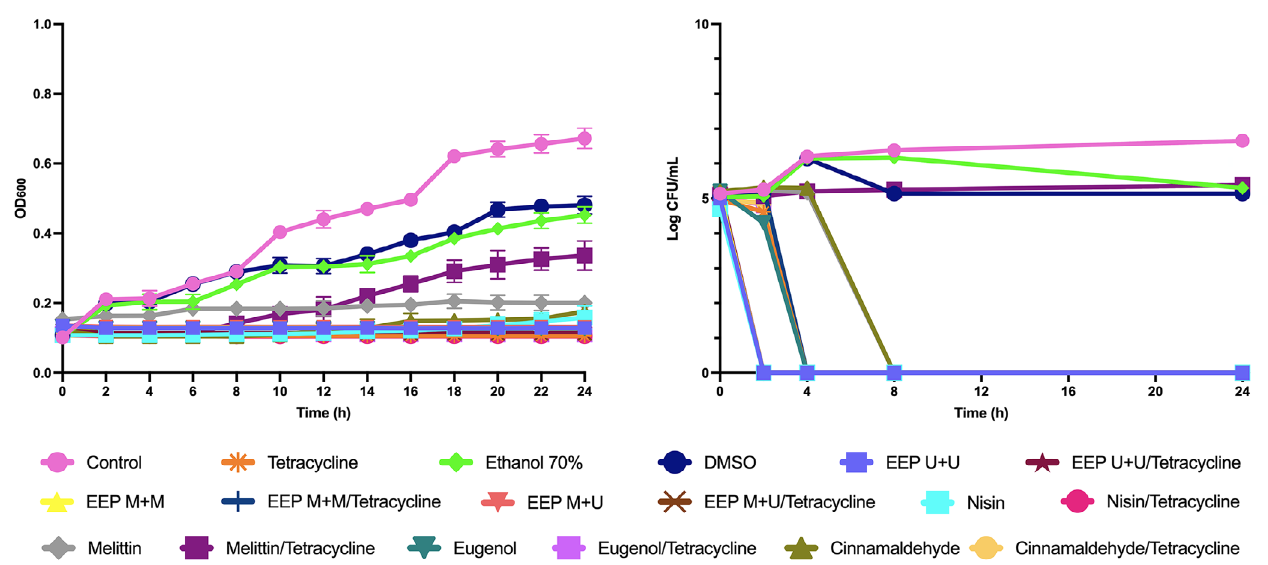
Figure 2. Time-kill curves from OD600 and Log of CFU/mL assays for EEPs, antimicrobial peptides, and major compounds and tetracycline tested alone and in combination with tetracycline on P. alvei .